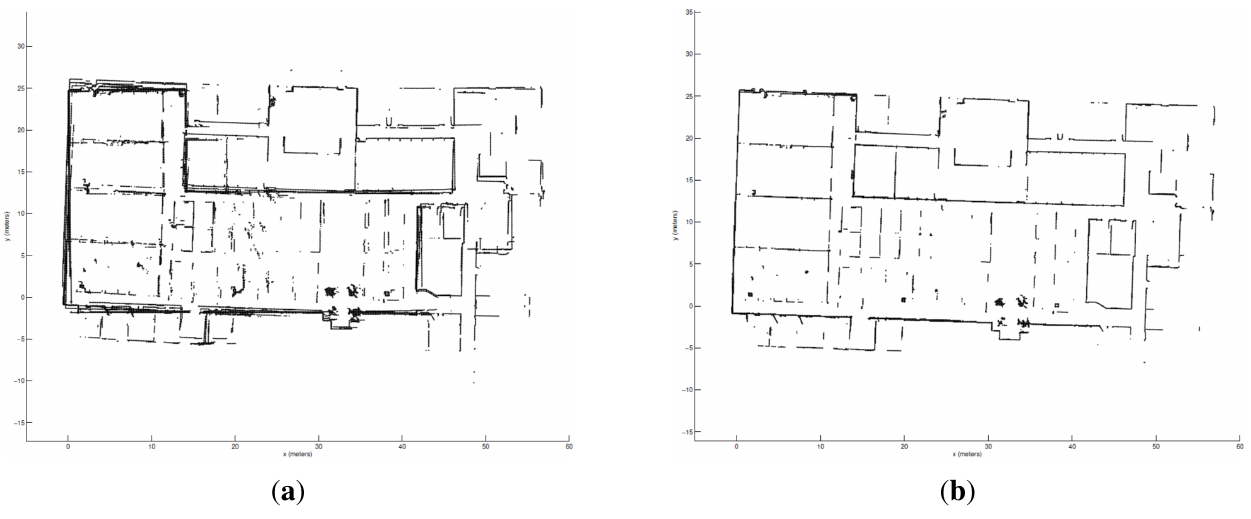
Figure 2. ( a ) An example map reconstructed using only dead reckoning and the start-to-end constraint. Many inaccuracies are visible in the reconstructed geometry. ( b ) An accurate map of the same environment created using the proposed